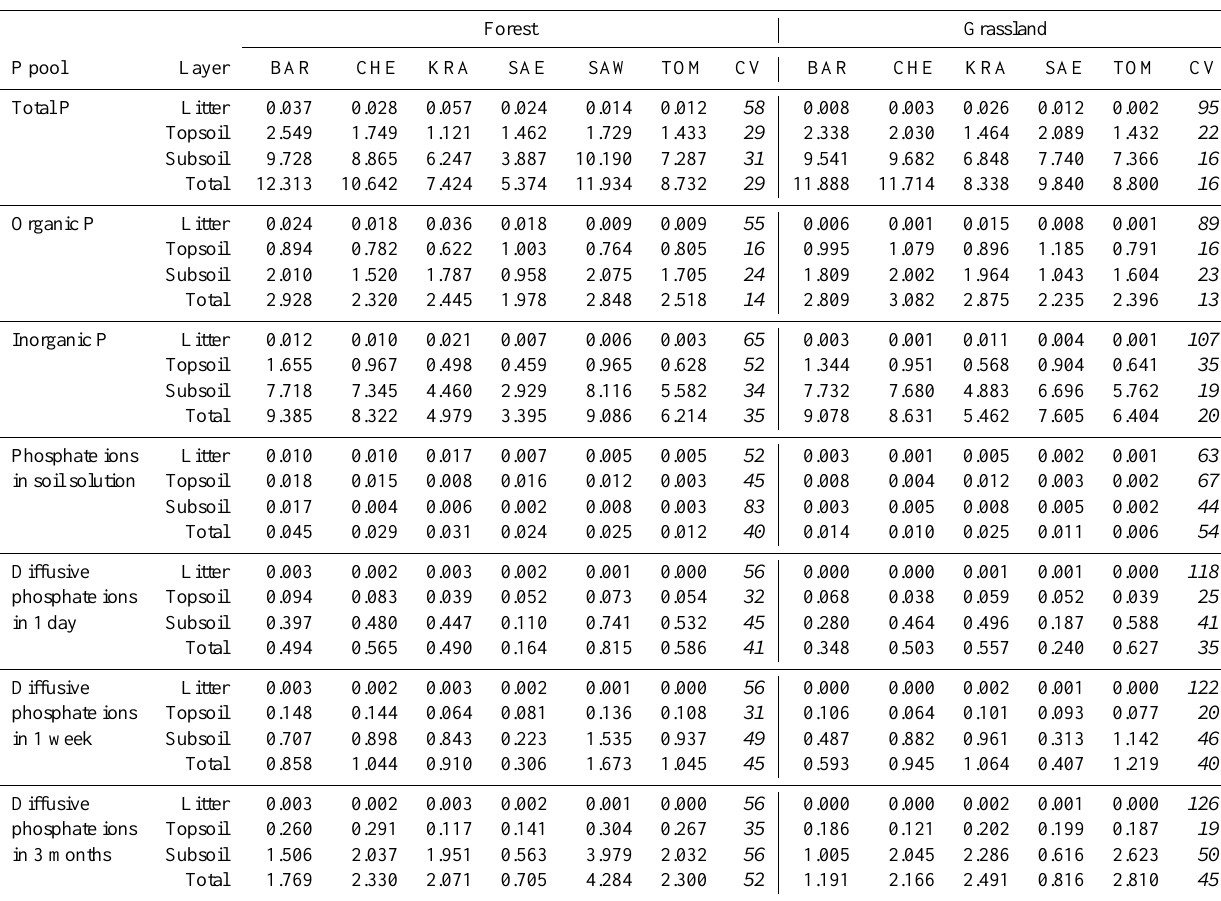
Table 3. Stocks of the different P pools computed in Mgha − 1 for the litter, the topsoil (about 0 to − 20cm), the subsoil (about − 20 to − 120cm) and for the whole profile for the different sites. “Litter” means all the dead plant material deposited on the soil surface (senescing leaf litterfall, small branches and senescing understorey vegetation in forests; senescing herbaceous vegetation in grasslands), i.e. mainly OL and OF horizons and possibly OH (at BAR, CHE, KRA and SAE) at the date of